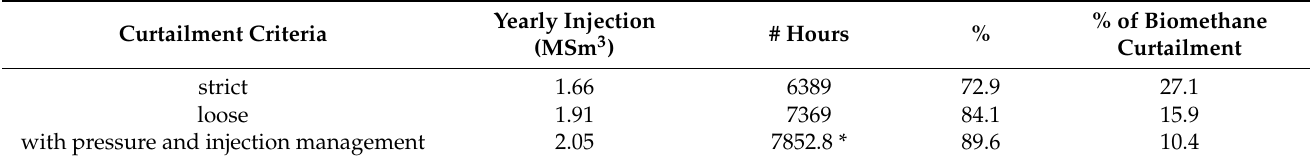
Table 5. Results of the preliminary production-consumption analysis in the business-as-usual injec- tion scenario under two different curtailment